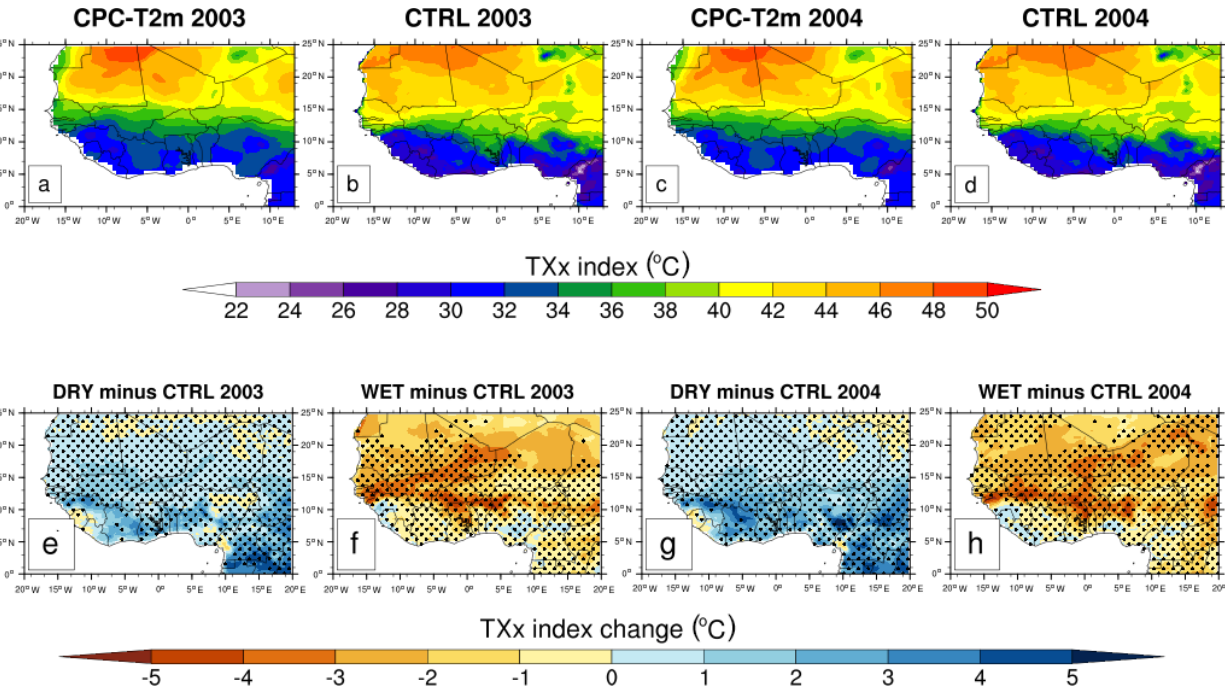
Figure 14. The mean maximum value of the daily maximum temperature (TXx index, in ◦ C) from CPC-T2m observations (a, c) for JJAS 2003 and JJAS 2004 and from the simulated control (CTRL) experiments (b, d) initialized with the initial soil moisture of the ERA- 20C reanalysis (top row), and changes in the TXx index (in ◦ C; bottom row) for JJAS 2003 and JJAS 2004 from dry (e, g) and wet (f, h) experiments with respect to the control experiments. Areas with values passing the 95% significance test are dotted. Table 5. Summary of the maximum values of change in PDFs for the TXx, TXn, TNn and TNx indices. Values in bold indicate regions with the largest changes in maximum values for the dry and wet experiments. Temperature Central Sahel West Sahel Guinea coast West Africa indices (cid:49)